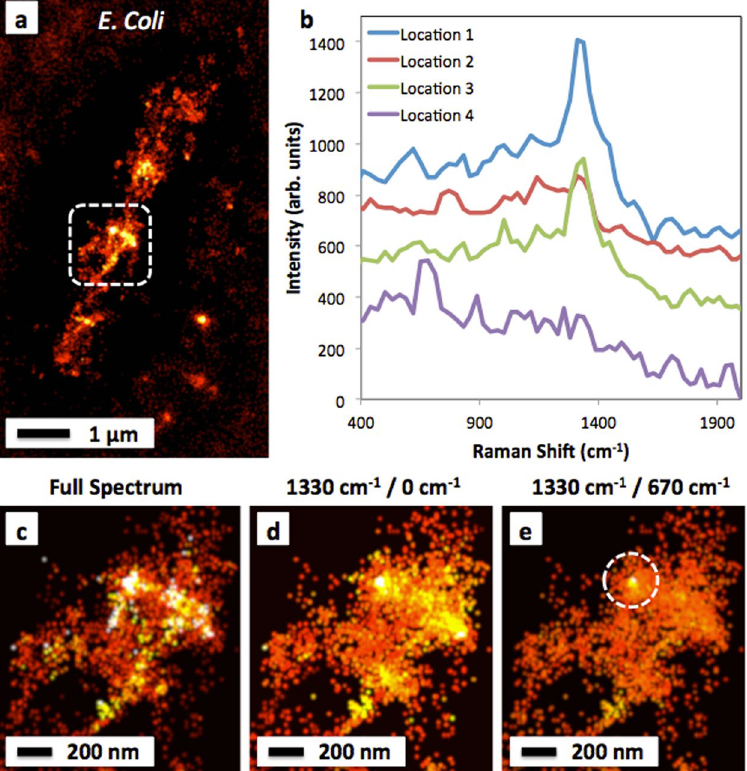
Figure 5. Features of the SERS-STORM data set. ( a ) An image of an E. Coli sample. ( b ) Several spectra have been extracted from the diffracted light on the CCD from various locations of the cell, scaled and shifted vertically to fit. ( c ) A zoomed view of the dashed region. This image has been produced from the zeroth order un-diffracted light, i.e. all of the SERS light with no spectral information. Using the spectral data shown in panel ( b ), it is possible to produce (d) an image of the ~1330 cm − 1 peak intensity normalized to the residual laser line intensity at 0 cm − 1 , thus removing inhomogeneities, or ( e ) an image of the ~1330 cm − 1 peak intensity normalized to the peak at ~670 cm − 1 . A region of interest circled in the image shows particularly intense ~1330 cm -1 light remaining after such